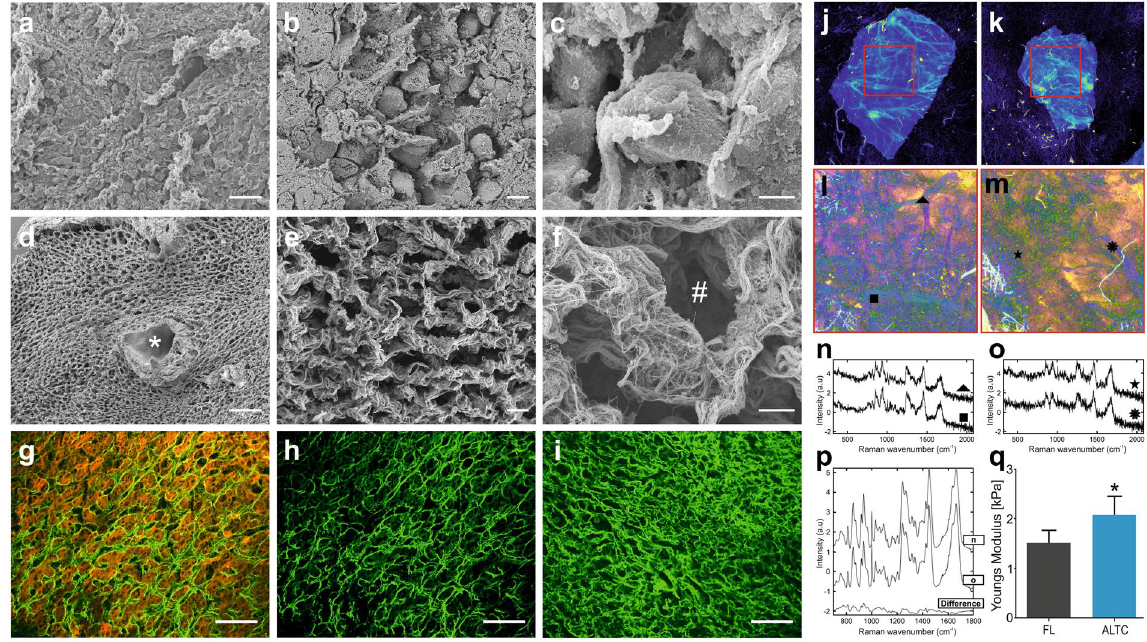
Figure 2. Confirmation of preservation of the micro-anatomy, biochemical and biomechanical properties of the ALTCs. SEM imaging of; ( a–c) , fresh liver samples, and ( d–f) , decellularized liver cubes showing the preservation of a portal tract (asterisks), collagen fibrils and hepatocyte pockets (octothorpe). Second harmonic generation analysis of fibrillar collagens structure (green) of ( g ), fresh liver samples with the presence of cells (red), ( h ), fresh liver samples with the subtraction of cells and ( i ), decellularized liver cubes. ( j,k ) Confocal auto-fluorescence microscopy showing preservation of the vascular trees in both samples. ( l,m ) Pseudo-colour images based on the first six components, highlighting the overall morphology of the tissue samples. ( n,o ) Raman spectra from different points on the cubes, showing similar spectra pattern to collagen. ( p ), Biochemical peaks of collagen proteins demonstrating no variability between the 2 decellularized cubes. ( q ) AFM comparison of tissue stiffness between fresh and decellularized liver cubes. Data are expressed as mean ± s.d. * , p < 0.05. Scale bars, 100 μ m ( a,d) , or 10 μ m ( b,c,e,f ), or 100 μ m ( g–i ). Biological replicates (n = 8) are performed for ( a–i) , or (n = 3) for q